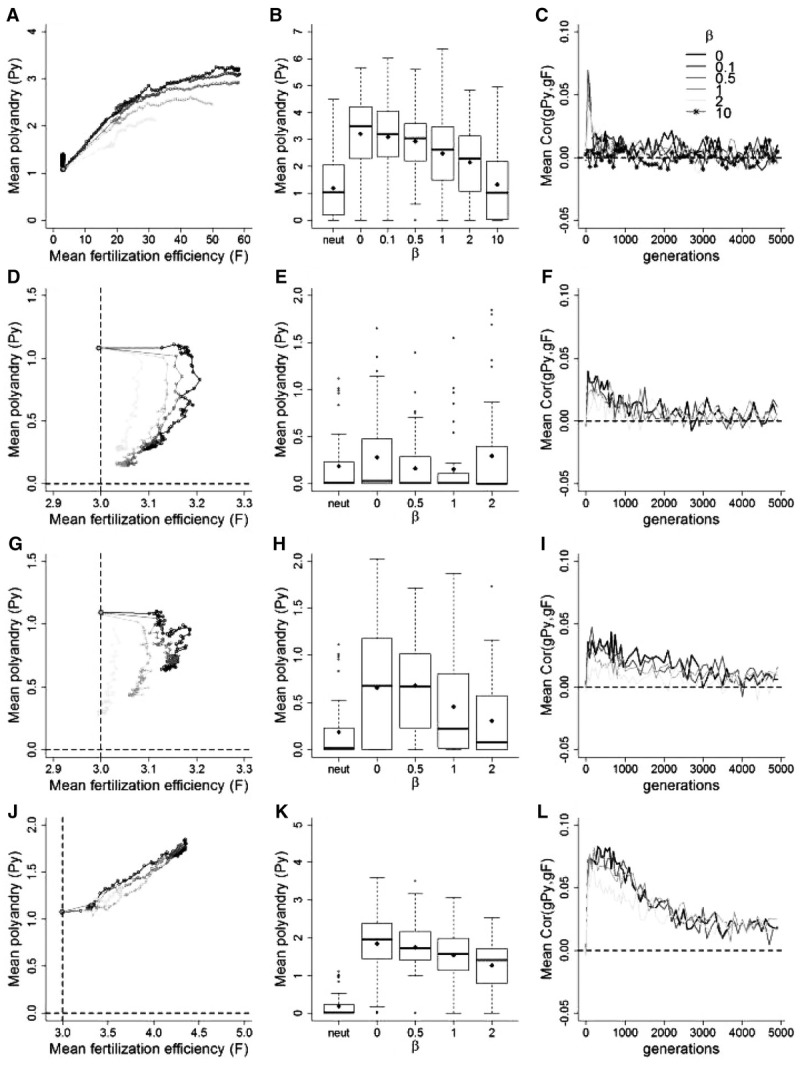
Effect of male precedence in fertilization (β) on coevolution between polyandry (Py) and fertilization efficiency (F). (A) Mean phenotypic values for Py and F for selected values of β in the absence of costs. Gray circles indicate the simulation starting values. (B) Mean phenotypic values for Py and neutral traits (“neutral”) subject to the same strength of direct selection at generation 5000, for different values of β, described as medians (solid bands), first and third quartiles (box limits), approximately twice the standard deviation (whiskers), and means (diamonds). (C) Mean correlations between Py and F for different values of β. (D–F) Same as in (A–C) when costs are applied to both traits (ω2Py = 400.0 and ω2F = 1.0). (G–I) Same as in (D–F) when, additionally to costs, substantial negatively biased mutations are applied to F (m′ = −0.35). (L–N) Same as in (G–I), with realized fertilization biased toward males with higher F (α = 5). All data are averaged over 50 replicate simulations, plotted every 50 generations until generation 1000 and every 100 generations thereafter. Dashed lines in (D) and (G) indicate the traits’ optima.